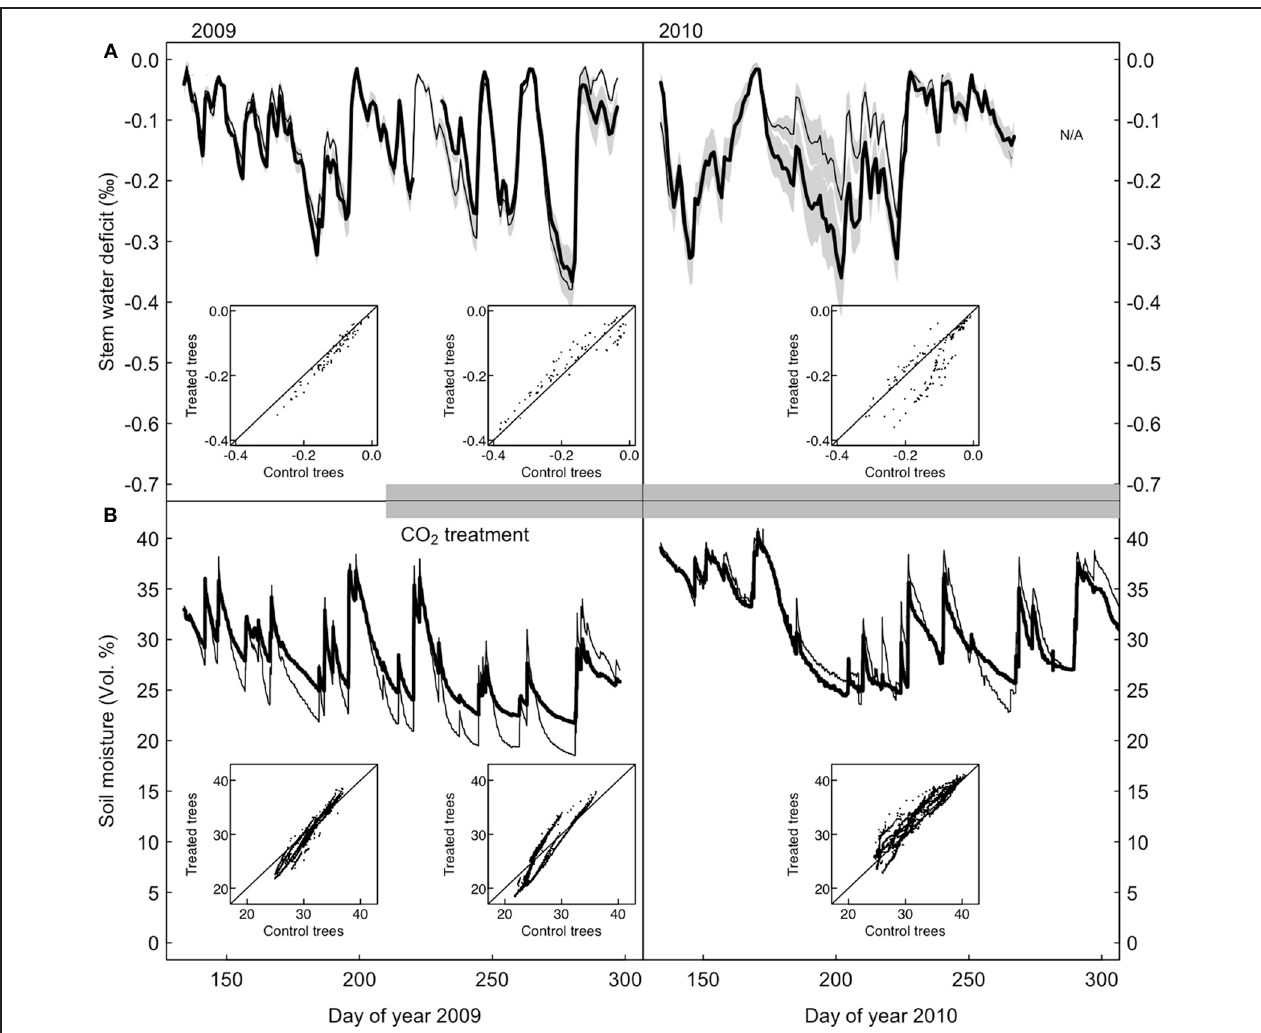
(B) Soil water content measured in the 10cm top soil layer for the control and treated area. The insets show that there are no systematic differences between CO 2 -treated and control trees during any of the three